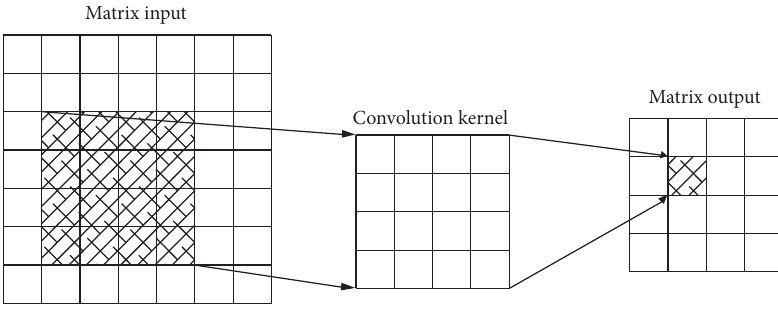
Figure 8: Schematic diagram of the convolution calculation principle.